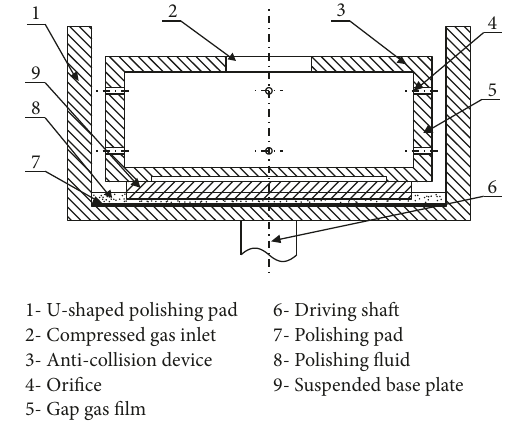
Figure 13: Schematic diagram of anticollision suspension pol- ishing device based on air pressure floating [70]. 1, U-shaped polishing pad; 2, compressed gas inlet; 3, anti-collision device; 4, orifice; 5, gap gas film; 6, driving shaft; 7, polishing pad; 8, polishing fluid; 9, suspended base